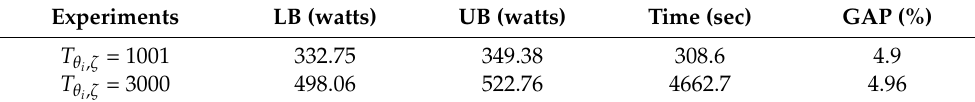
Figure 7. ( a ) Result when T θi,ζ is set to 1001; ( b ) Result when T θi,ζ is set to 3000. Table 4. LR Results of Many-to-many WSN Transmission Experiment.